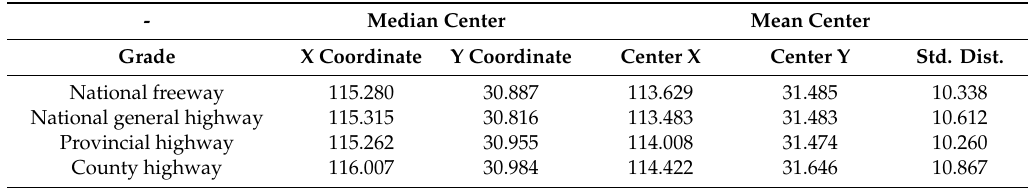
Table 4. Descriptive statistics of standard deviation ellipse